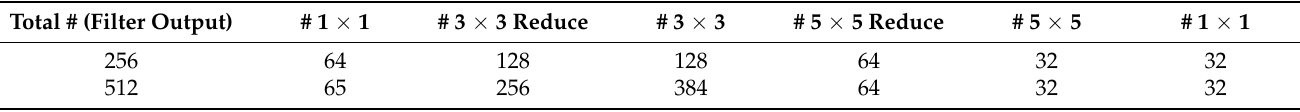
Figure 5. Diagram of the Inception module. The filter numbers used for each layer are given in Table 3. Table 3. Filter numbers for each convolution type in the Inception module. Note: “ n × n Reduce” stands for the 1 × 1 convolutions preceding the corresponding n × n